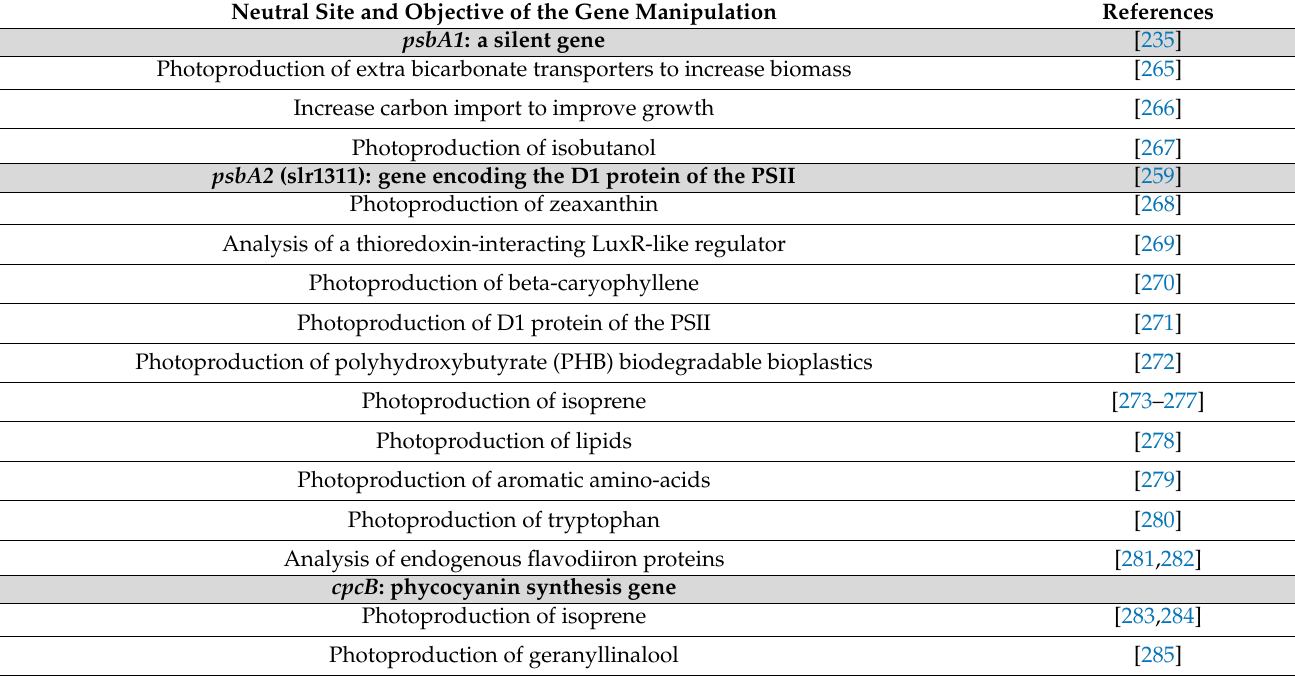
Table 1. Literature on the utilization of neutral chromosomal cloning sites in Synechocystis PCC 6803. Neutral Site and Objective of the Gene